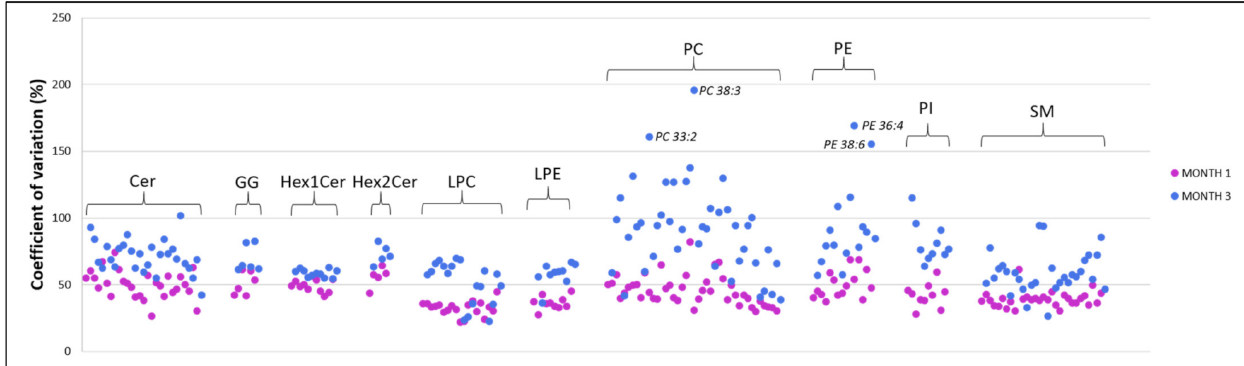
Figure 2. Variation (CV%) in the infant intake for each MFGM lipid species in months one and three. The species that display the highest CV (>150%) are labelled. Cer, ceramide; GG, ganglioside; Hex1Cer, monohexosylceramide; Hex2Cer, dihexosylceramide; LPC, lysophosphatidylcholine; LPE, lysophosphatidylethanolamine; PC, phosphatidylcholine; PE, phosphatidylethanolamine; PI, phosphatidylinositol; and SM,